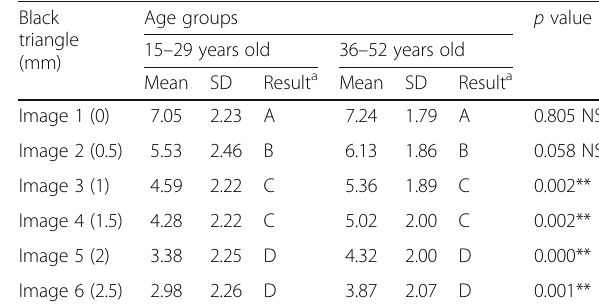
Table 2 Photograph ratings by age group of altered incisal edge positions of the maxillary central incisors